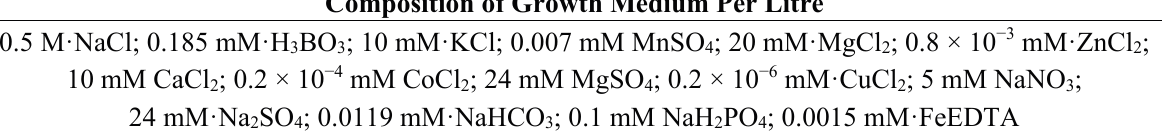
Table 3. D. salina culture